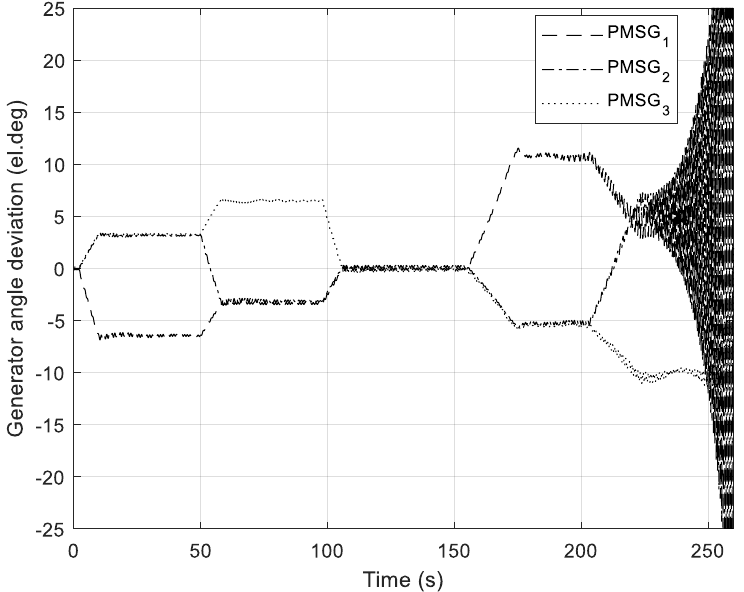
Figure 10. Deviations of rotor angles for control system with disabled P pitch controller.